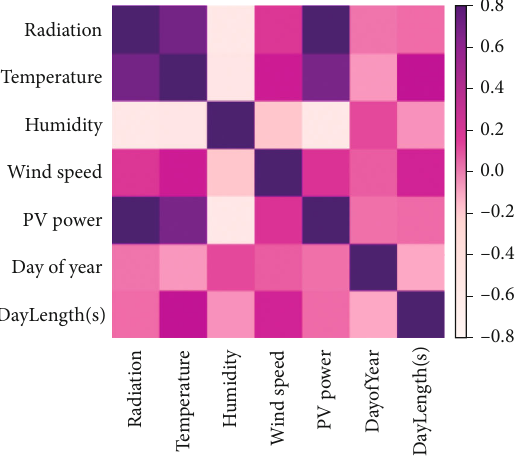
Figure 9: Correlation the Pearson